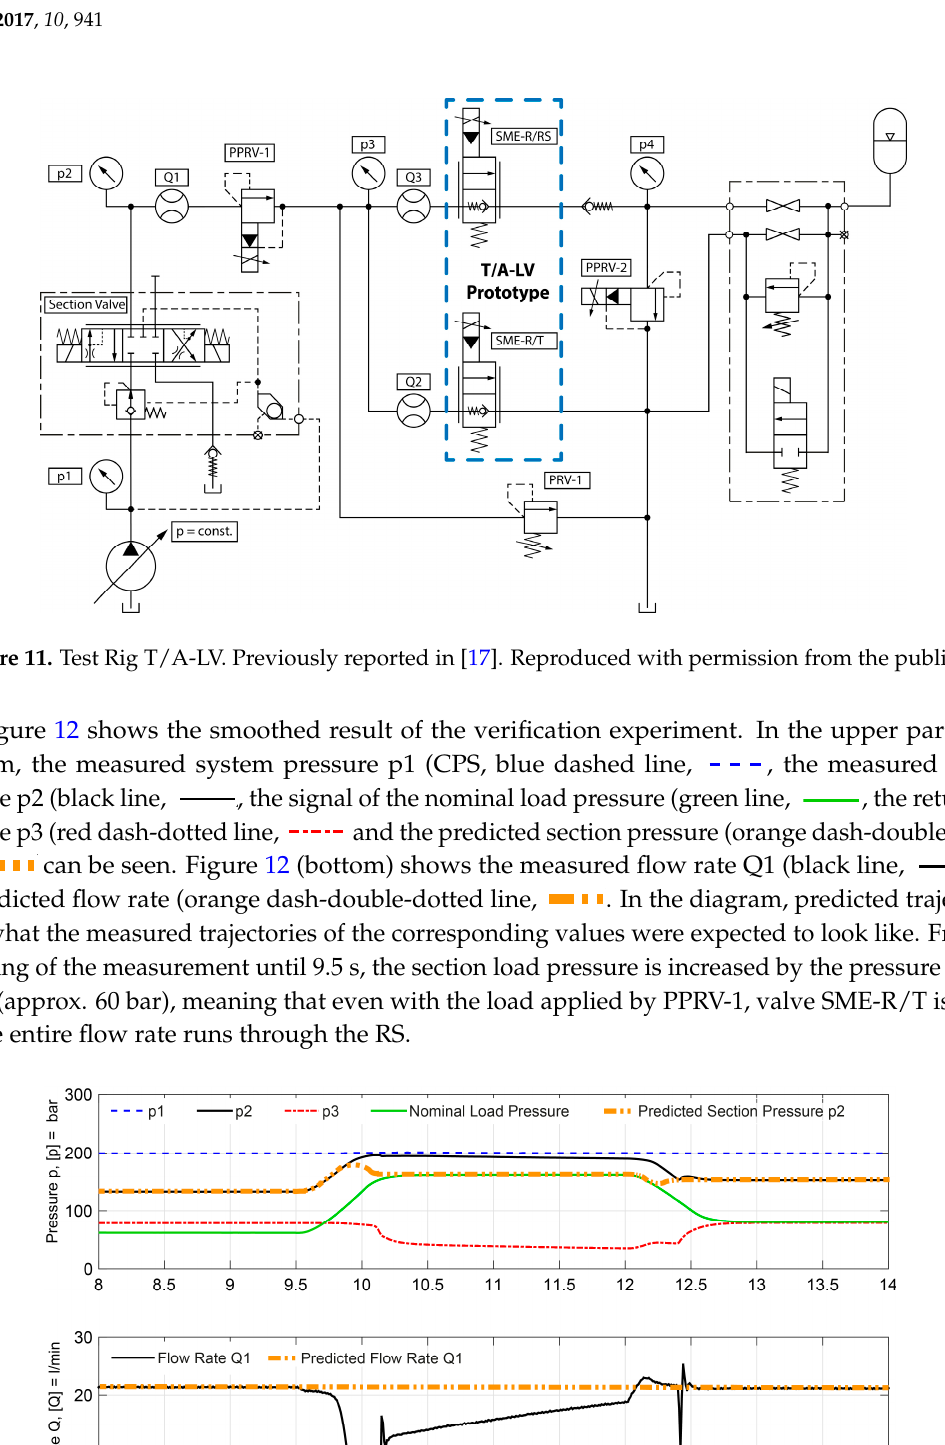
Figure 12. Verification of the T/A-LV prototype. Previously disclosed in [17]. Reproduced with permission from the publisher.